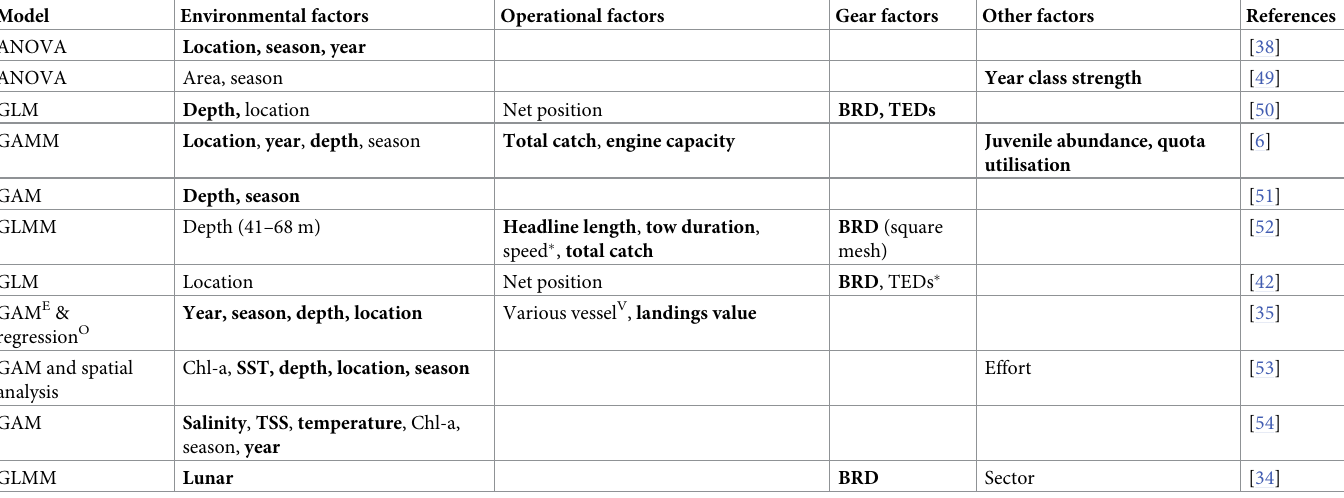
Table 4. Sample of studies that model the rate of discarding in demersal trawl fisheries.